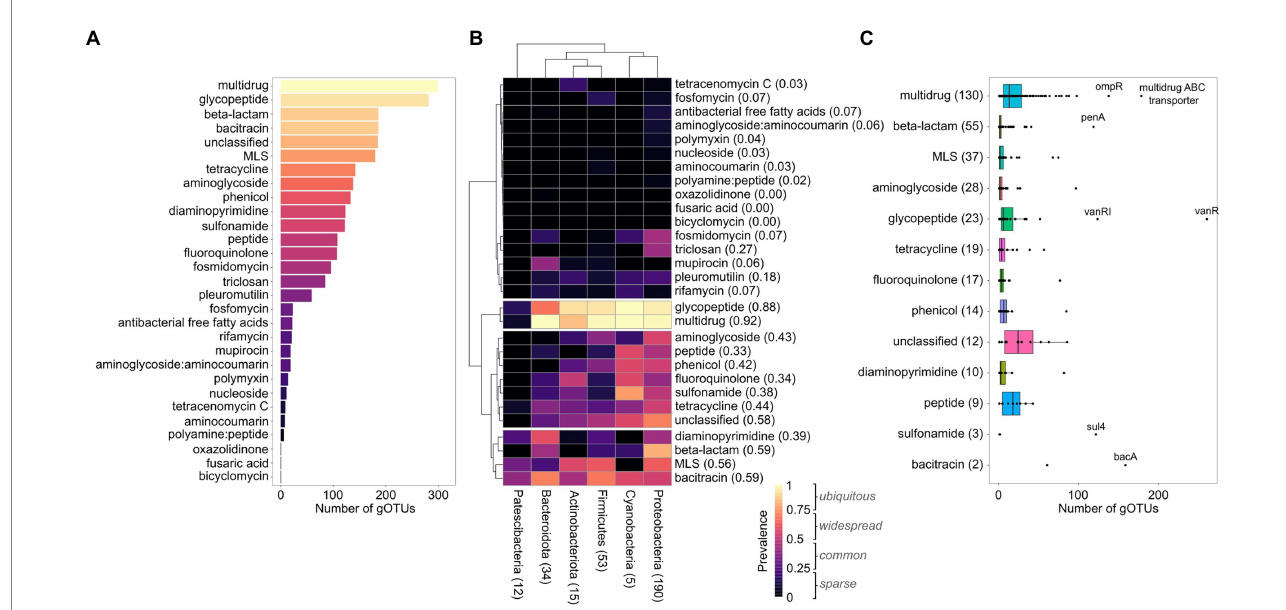
FIGURE 2 Prevalence of antimicrobial resistance gene classes in urban bacteria. (A) A bar plot showing the number of gOTUs that contain ARGs belonging to each ARG class. Colors refer to the prevalence of each ARG class in all gOTUs (i.e., species). (B) A heatmap showing the prevalence of ARG classes in the urban taxonomic phylum level. Shown are the number of gOTUs that belong to each phylum. Only phyla with five or more gOTUs are shown. The dendrogram is based on hierarchical clustering with Ward distance between the ARG class prevalence among the four phyla. The weighted average prevalence (WAP) of the ARG class on the phylum level is in parentheses. In gray within the legend, we show the ranges of our defined prevalence categories. (C) Boxplots showing the number of gOTUs that contain each ARG within the ARG classes that were present in the ubiquitous, widespread, and common categories from (B) . In parentheses are the number of ARGs within the ARG class. ARGs present in at least 1/3 of the gOTUs are labeled.